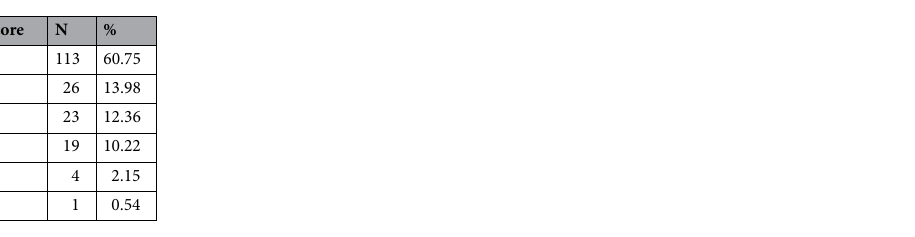
Table 3. Radicular groove type observed in mandibular first premolars according to the ASUDAS scoring.